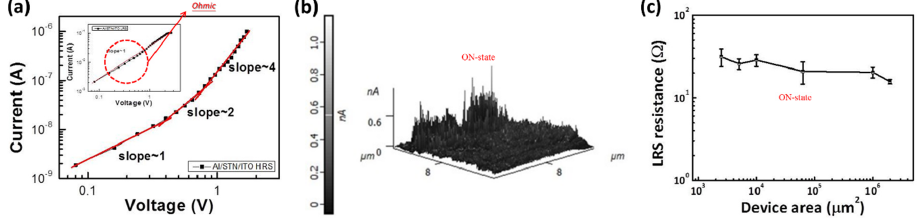
Figure 4. ( a ) Log I ‐ V curve; ( b ) Current ‐ sensing atomic force microscopy image devices in the LRS; and ( c ) area dependence of LRS resistance of STN memory device.